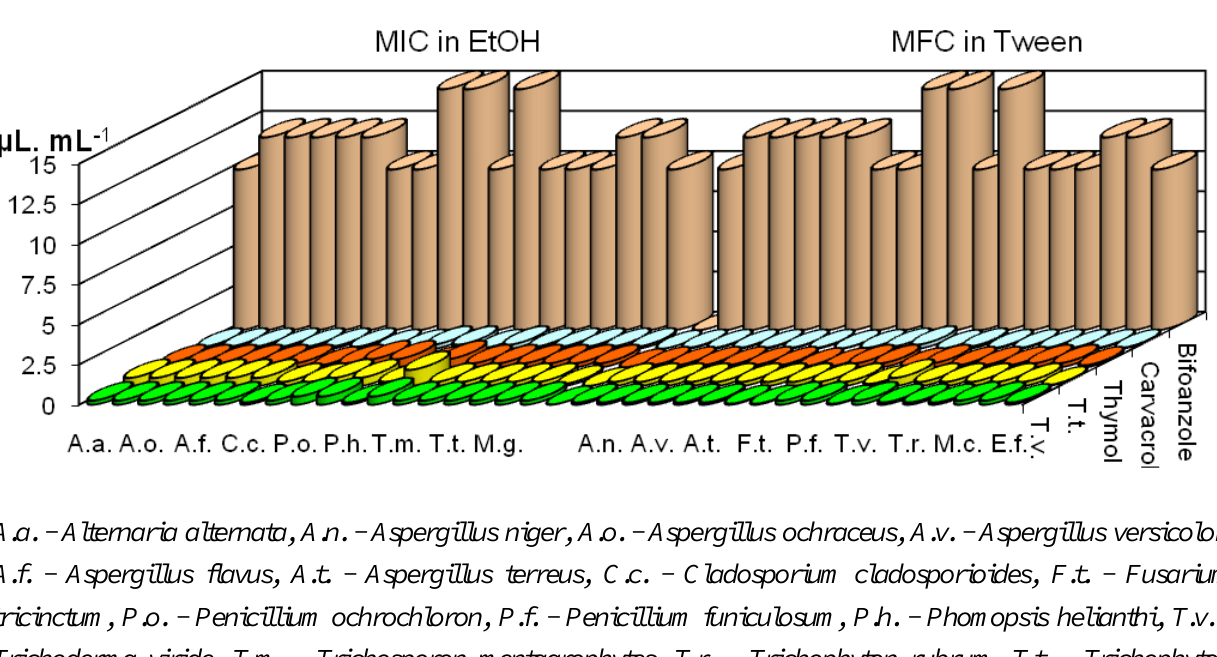
Figure 1. MIC ( μ L·mL -1 ) in EtOH (macrodilution method) of oils of T. vulgaris and T. tosevii and their components and MFC ( μ L·mL -1 ) in Tween ® (microdilution